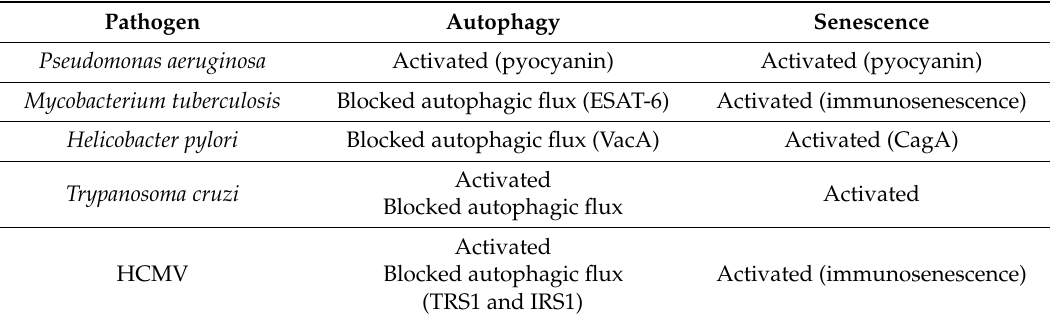
Figure 3. One of the consequences of the aging process is the diminution of autophagic capacity. Consequently, this diminution predisposes the individual to accumulation of cellular damage and senescence activation. In the immune system, this process is called immunosenescence and is accompanied by chronic inflammation. Several pathogens that induce chronic infections are able to activate or accelerate the immunosenescence process and in this way, their elimination by the host tends to be less effective. Table 2. Effect of pathogens on autophagy and senescence.